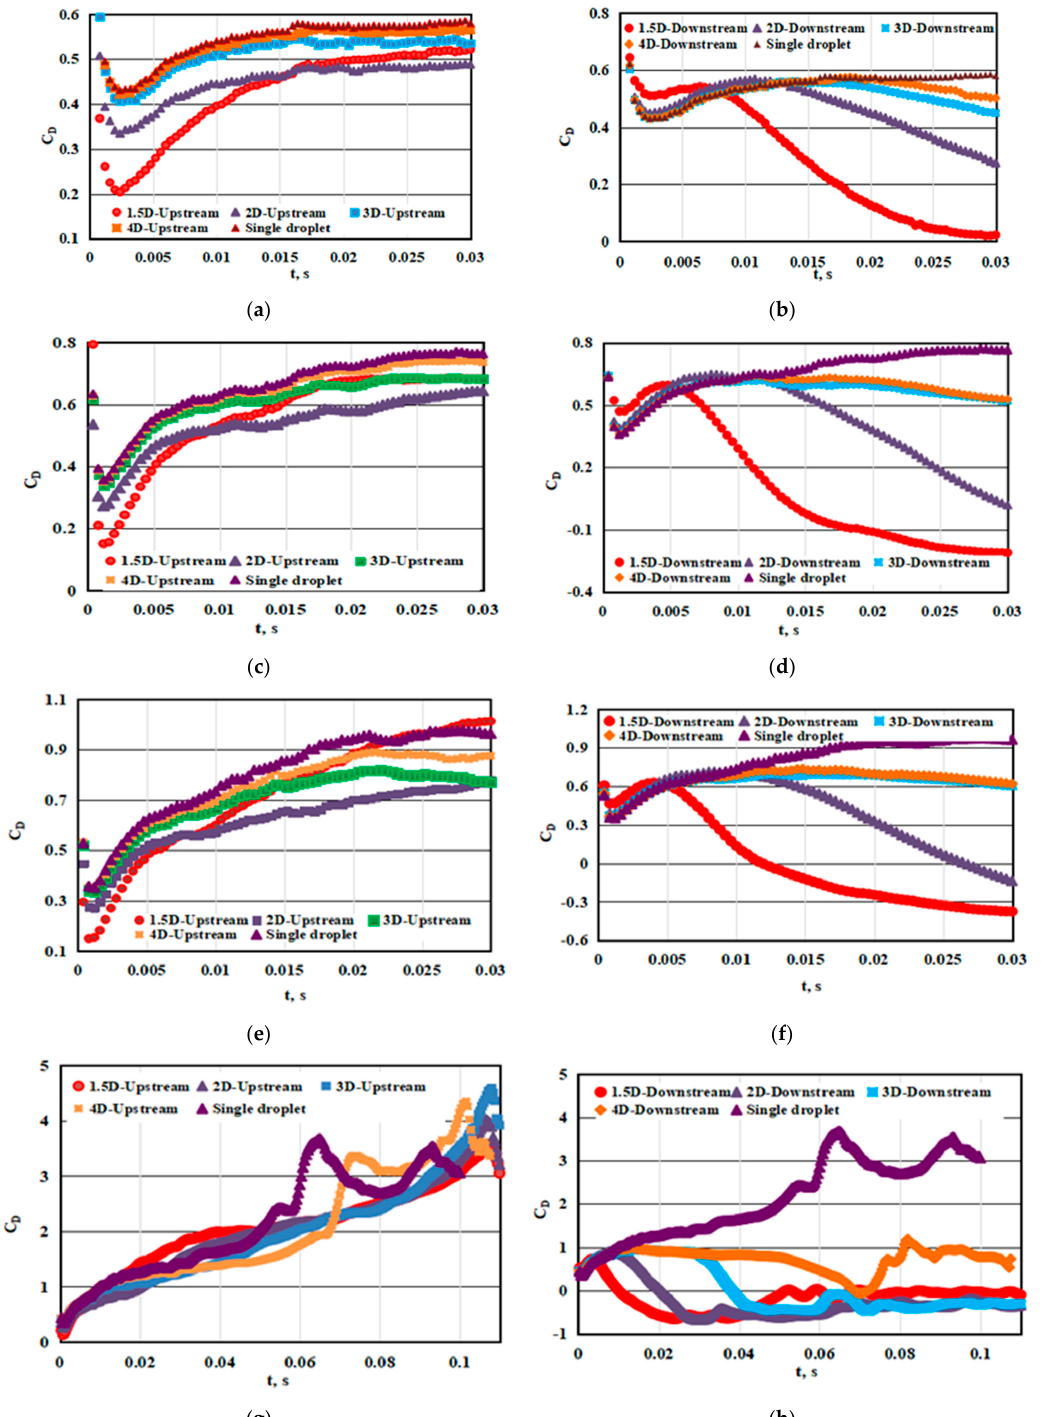
Figure 7. Drag coefficients for different separating spaces between droplets and different Weber numbers. ( a ) Upstream droplet, U G = 0.68 m/s, Re = 594, We = 1. ( b ) Downstream droplet, U G = 0.68 m/s, Re = 594, We = 1. ( c ) Upstream droplet, U G = 1.36 m/s, Re = 1171, We = 4. ( d ) Downstream droplet, U G = 1.36 m/s, Re = 1171, We = 4. ( e ) Upstream droplet, U G = 1.78 m/s, Re = 1556, We = 6.8. ( f ) Downstream droplet, U G = 1.78 m/s, Re = 1556, We = 6.8. ( g ) Upstream droplet, U G = 2.36 m/s, Re = 2063, We = 12.1. ( h ) Downstream droplet, U G = 2.36 m/s, Re = 2063, We =